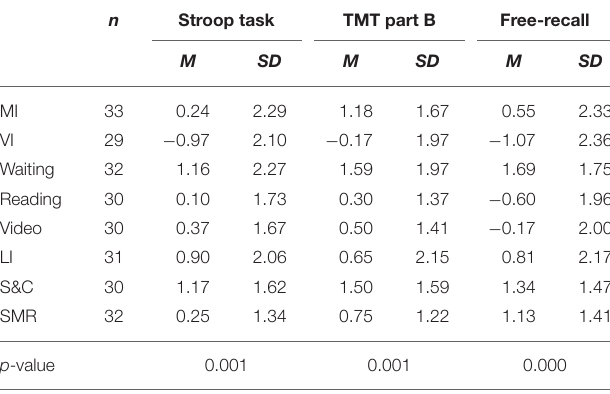
TABLE 3 | Means and SD of participants’ expectation ratings ( − 5 to 5) toward the different described treatments regarding its effect on cognitive test performance.